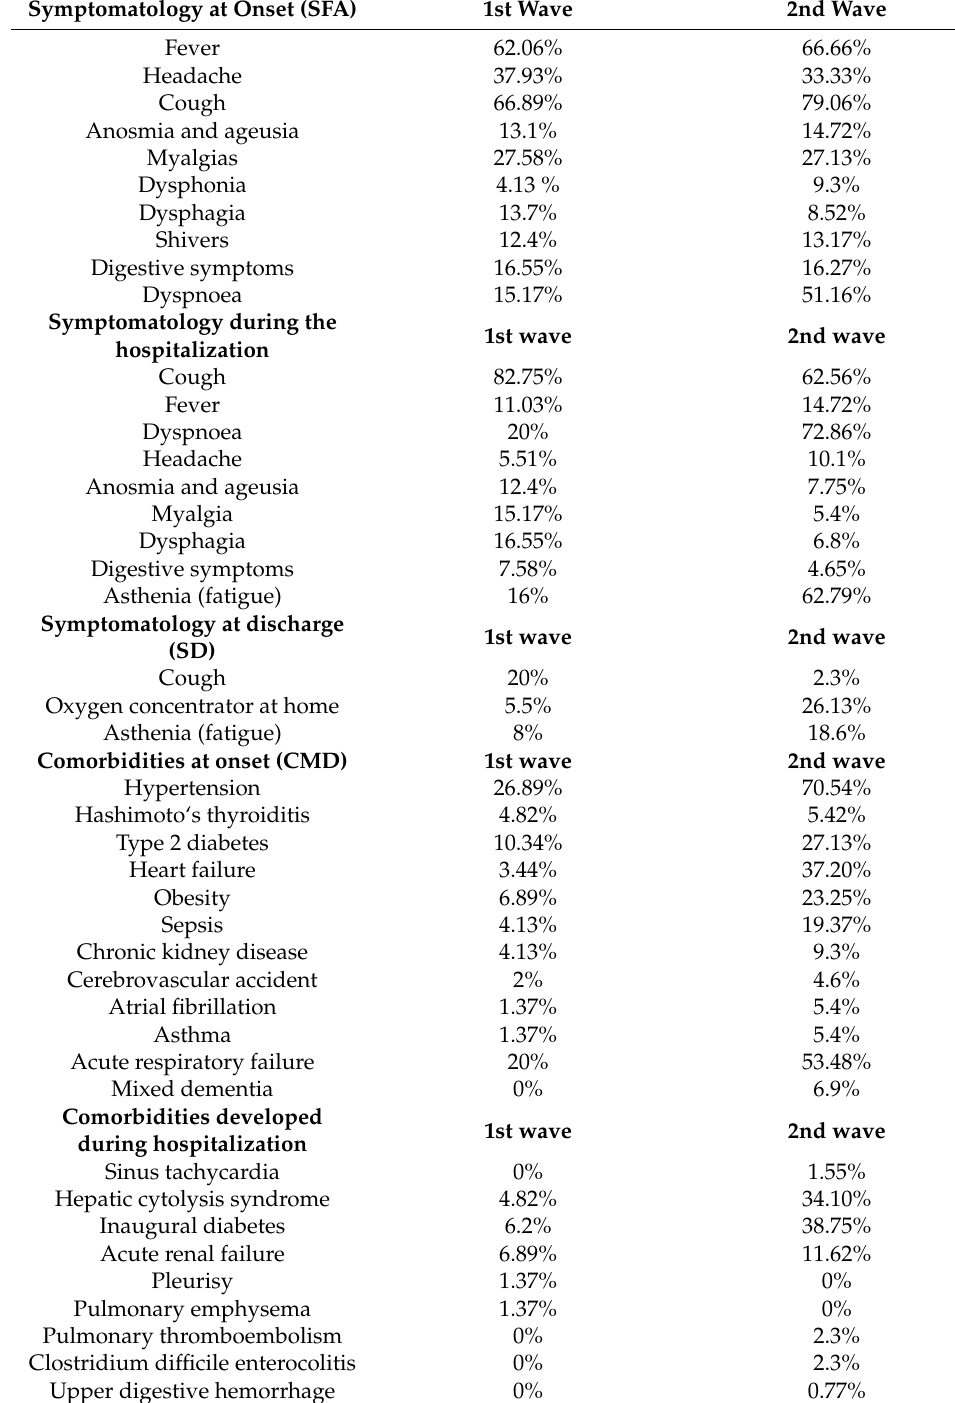
Table 4. Symptomatology and comorbidities of 274 SARS-COV2 patients considered in the analysis. Symptomatology at Onset